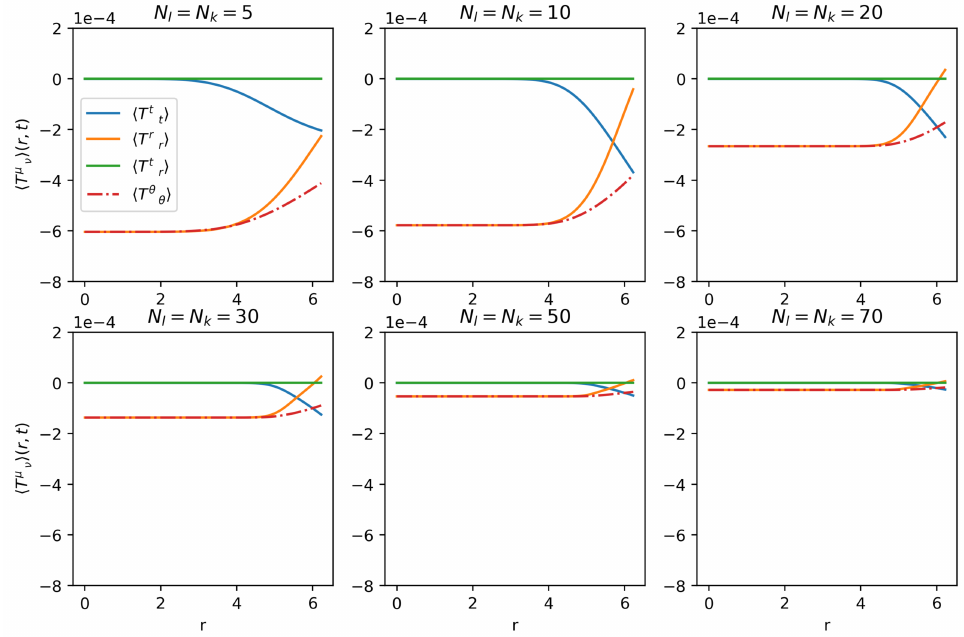
Figure 1 . Expectation values of the stress-energy tensor components in the case of zero coherent state expectation value for various numbers of quantum mode functions included, with equal number of l -modes and k